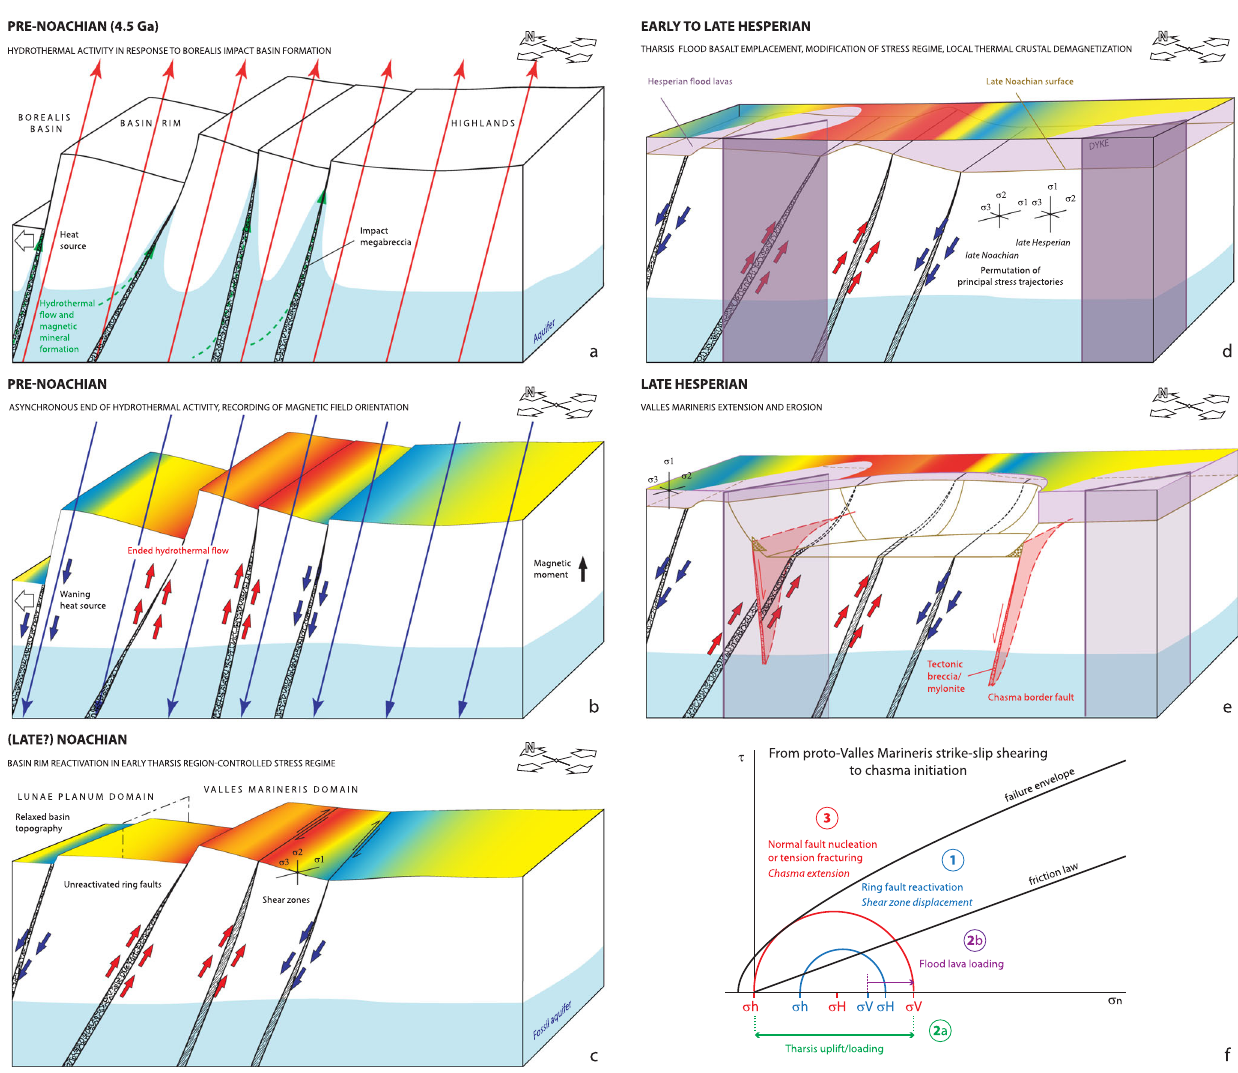
Fig. 5 Proposed scenario of the evolution of the Valles Marineris crust. a – e Crustal evolution stages. f Pre-Noachian to Hesperian evolution of stress state and brittle deformation of the Valles Marineris crust in response to Tharsis thermal